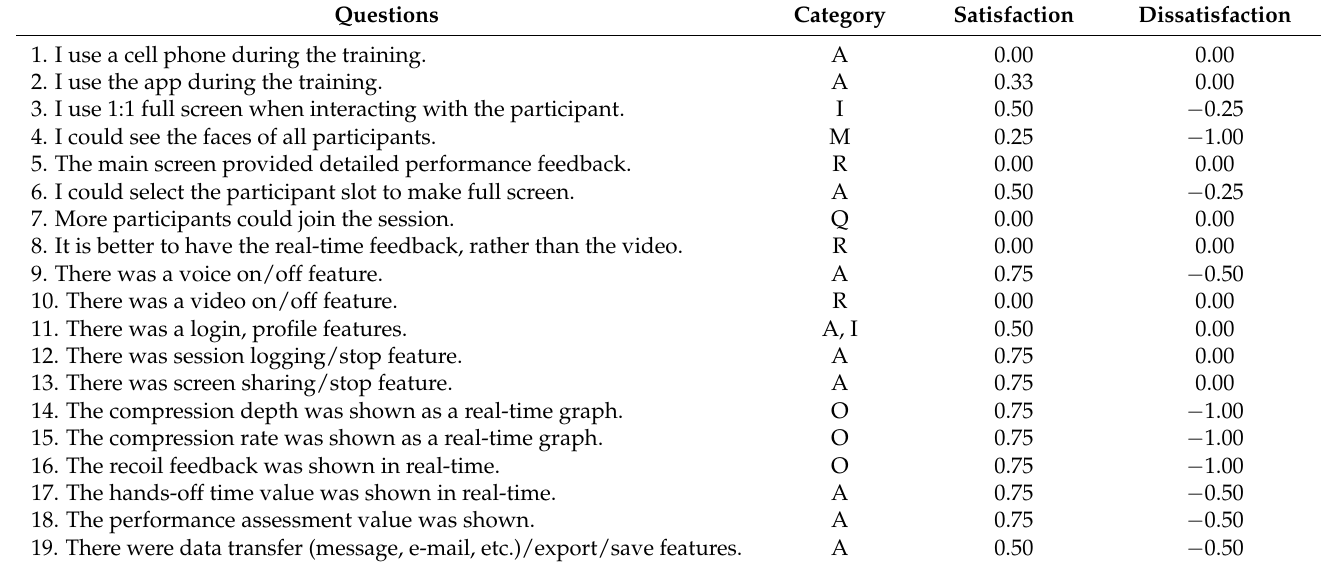
Table 2. Questions for Instructors ( n = 4).